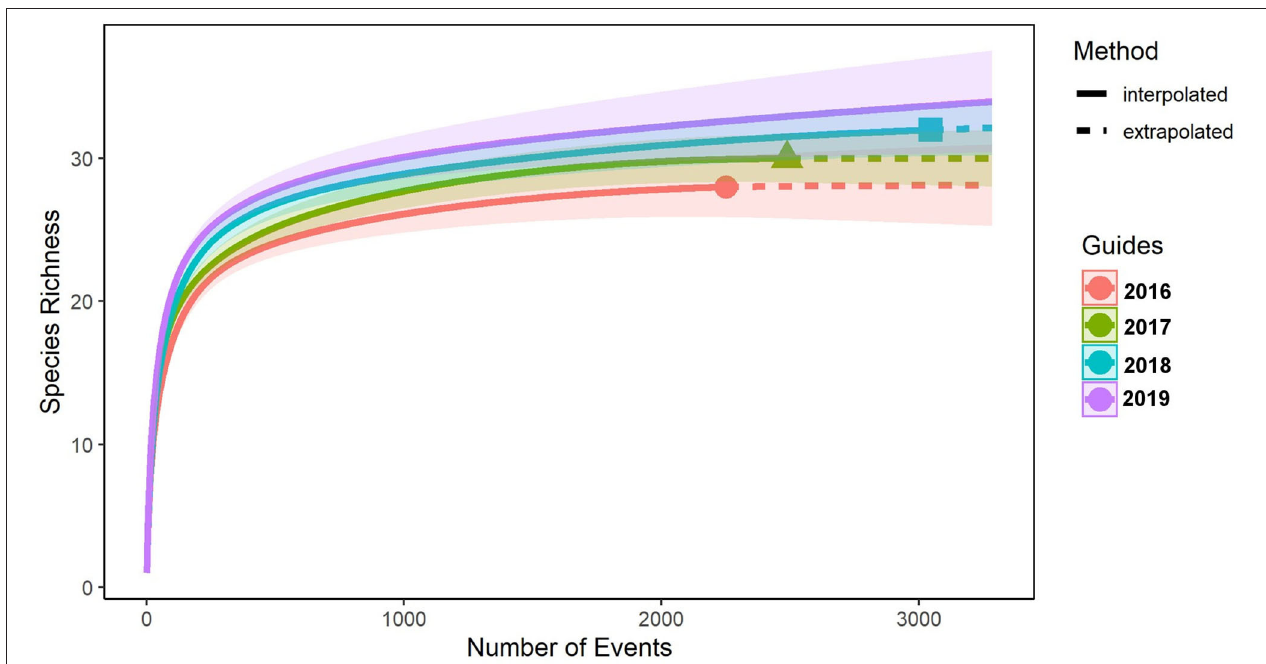
FIGURE 2 | Species accumulation curves for all camera sites on the wildlife-friendly farm.